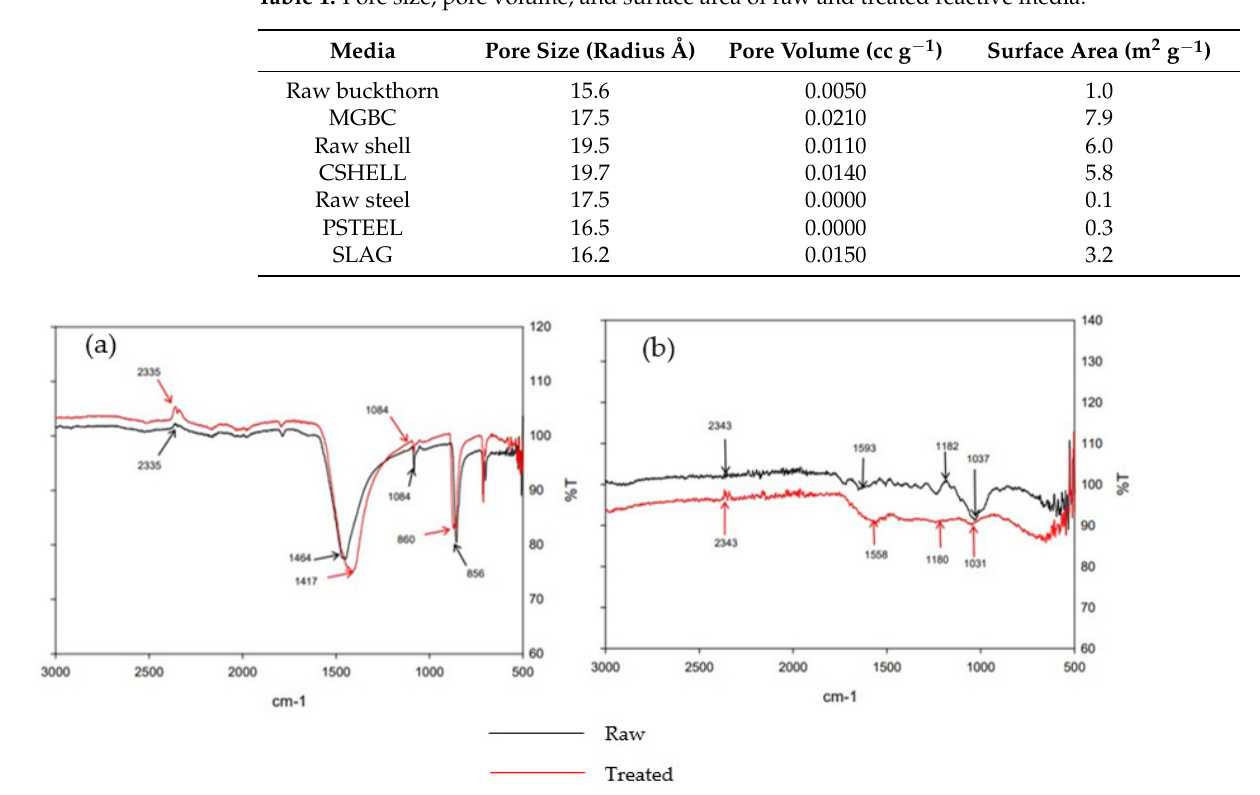
Table 1. Pore size, pore volume, and surface area of raw and treated reactive media.